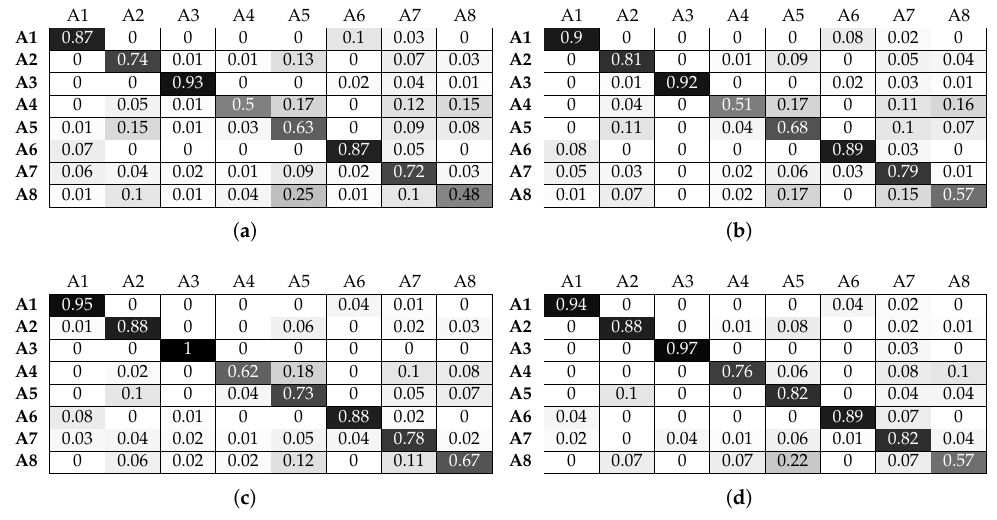
Figure 14. Normalised confusion matrices for random forest, with Wearable Feature Type 2, without beacon data. ( a ) 49, w = 1 s; ( b ) 50, w = 2 s ; ( c ) 43, w = 3 s; ( d ) 45, w = 4 s. Sensors 2017 , 17 , x